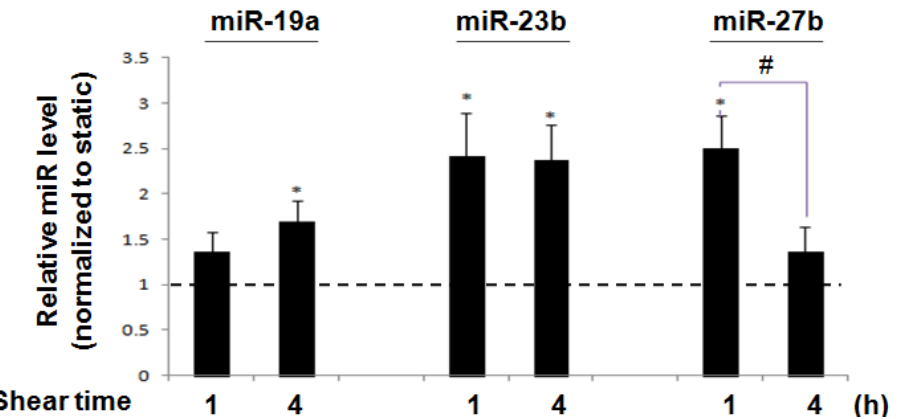
Figure 1. Shear stress regulation of endothelial cells. Laminar shear stress regulated miR expressions. QRT-PCR shows that laminar shear stress (12 dyne/cm 2 ) significantly upregulated miR-19a at 4h, miR-23b at 1 h and 4 h, and miR-27b at 1 h. * p < 0.05 (compared with 1), # p < 0.05 between two time points. Data are mean ± SEM (n =